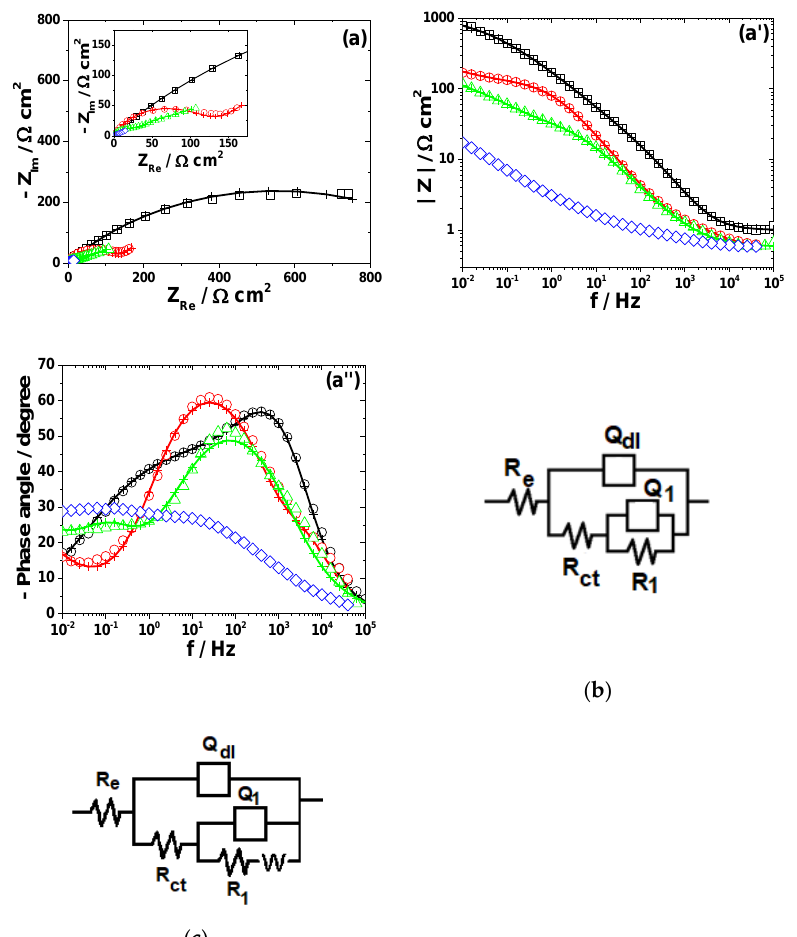
Figure 6. EIS results of Pb after immersion in different bromide-based electrolytes: Nyquist diagrams ( a ); Bode plot of |Z| vs. frequency ( a’ ); and Bode plot of phase angle vs. frequency ( a” ). The equivalent electrical circuits used for EIS fitting ( b , c ). Symbols represent the experimental data and lines with cross (—+—) correspond to the simulated spectra. Electrolytes: (□) Sol. A; ( O ) Sol. B; (◊) Sol. C; and (Δ) Sol. D.